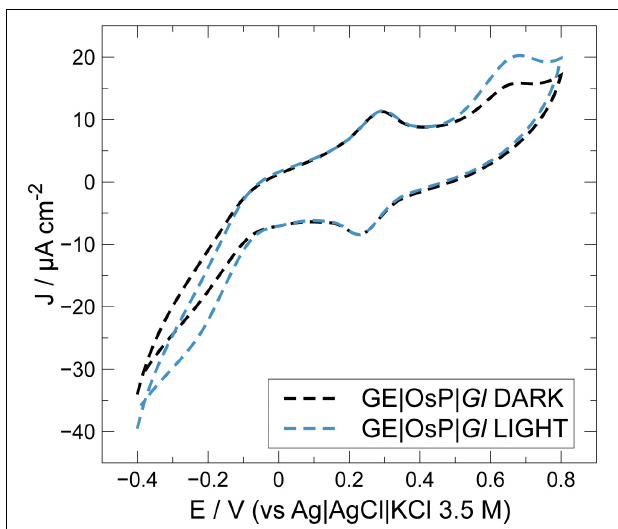
FIGURE 5 | Effect of OsP on current density outputs during cyclic voltammetry experiments at electrodes modified with GE| OsP| Gl .